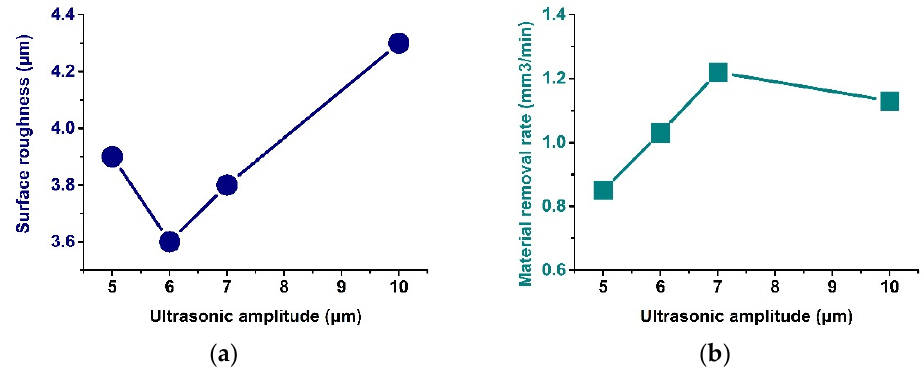
Figure 16. Roughness and material removal rate results of different specimens under different ultrasonic amplitudes: ( a ) roughness results; ( b ) material removal rate results.